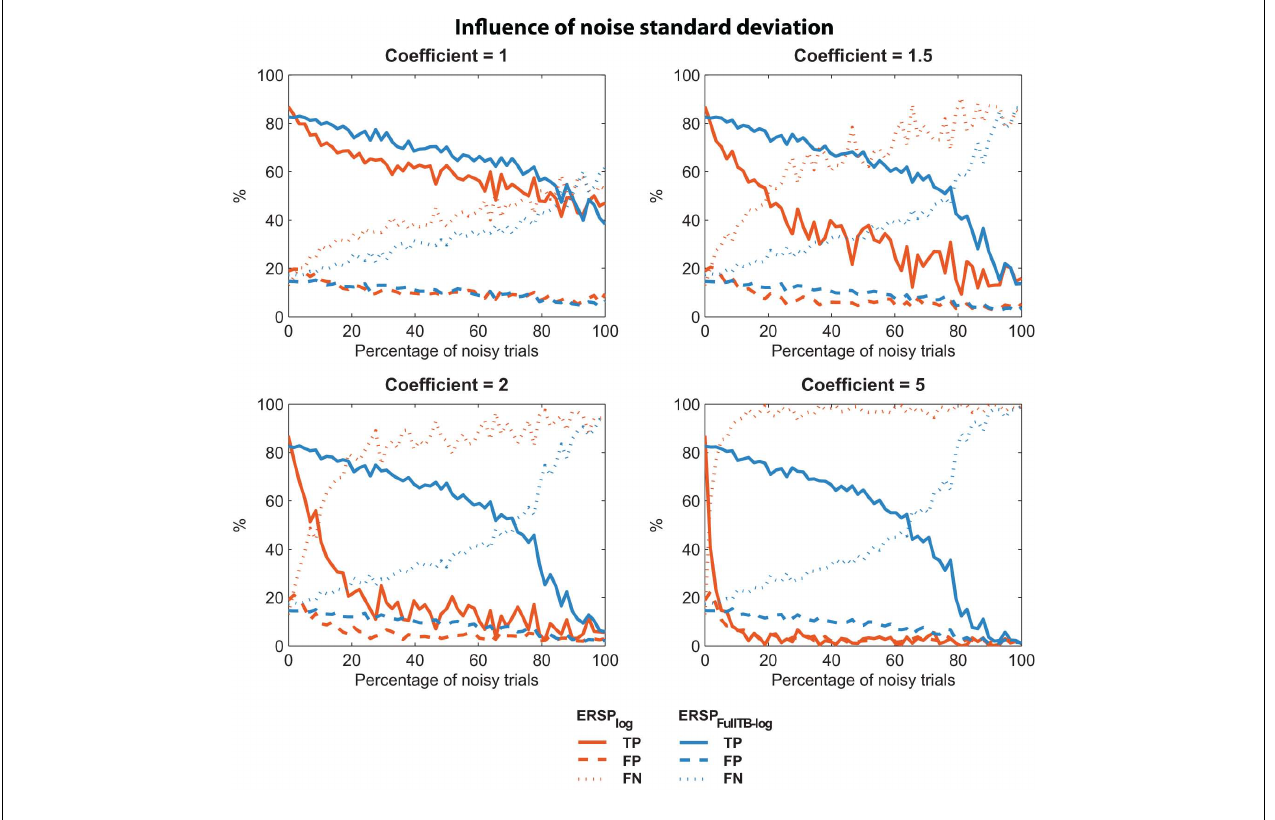
outperforms the classical method (ERSP log ) with a higher rate ofTrue Positive significant values and a comparable rate of False Negative significant values.